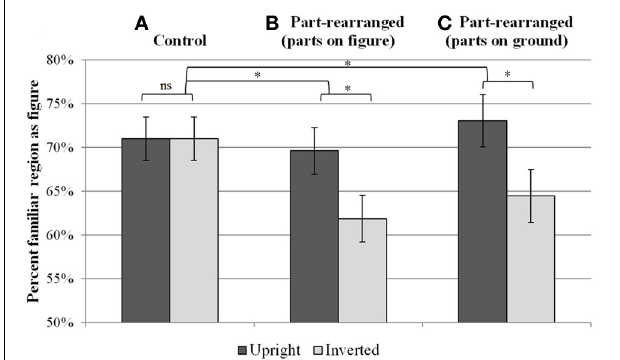
FIGURE 4 | Mean percent of trials on which the familiar region was reported as the figure for each of the between-subjects conditions. Results of Experiment 1 are shown in (A) for the control condition and (B) for the part-rearranged condition in which the familiar parts were depicted on the figure side of the prime’s borders. Results of Experiment 2 are shown in (C) for the part-rearranged condition in which the familiar parts were suggested in on the groundside of the prime’s borders. Error bars represent standard error of the mean of the difference scores (upright-inverted). ∗ p < 0 .